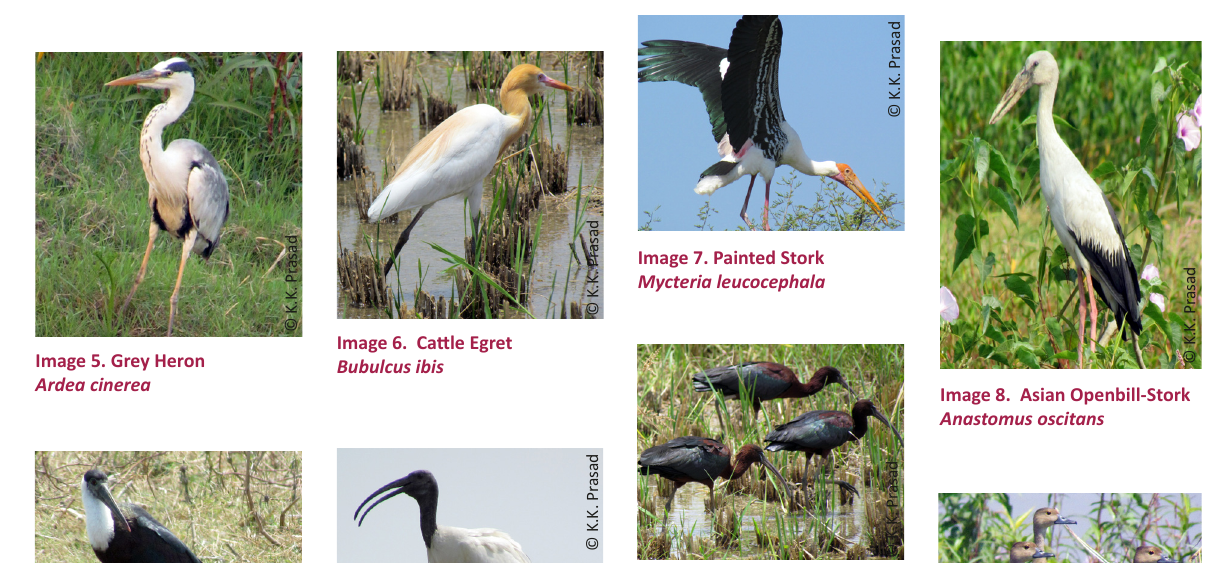
Image 4. Purple Heron Ardea purpurea